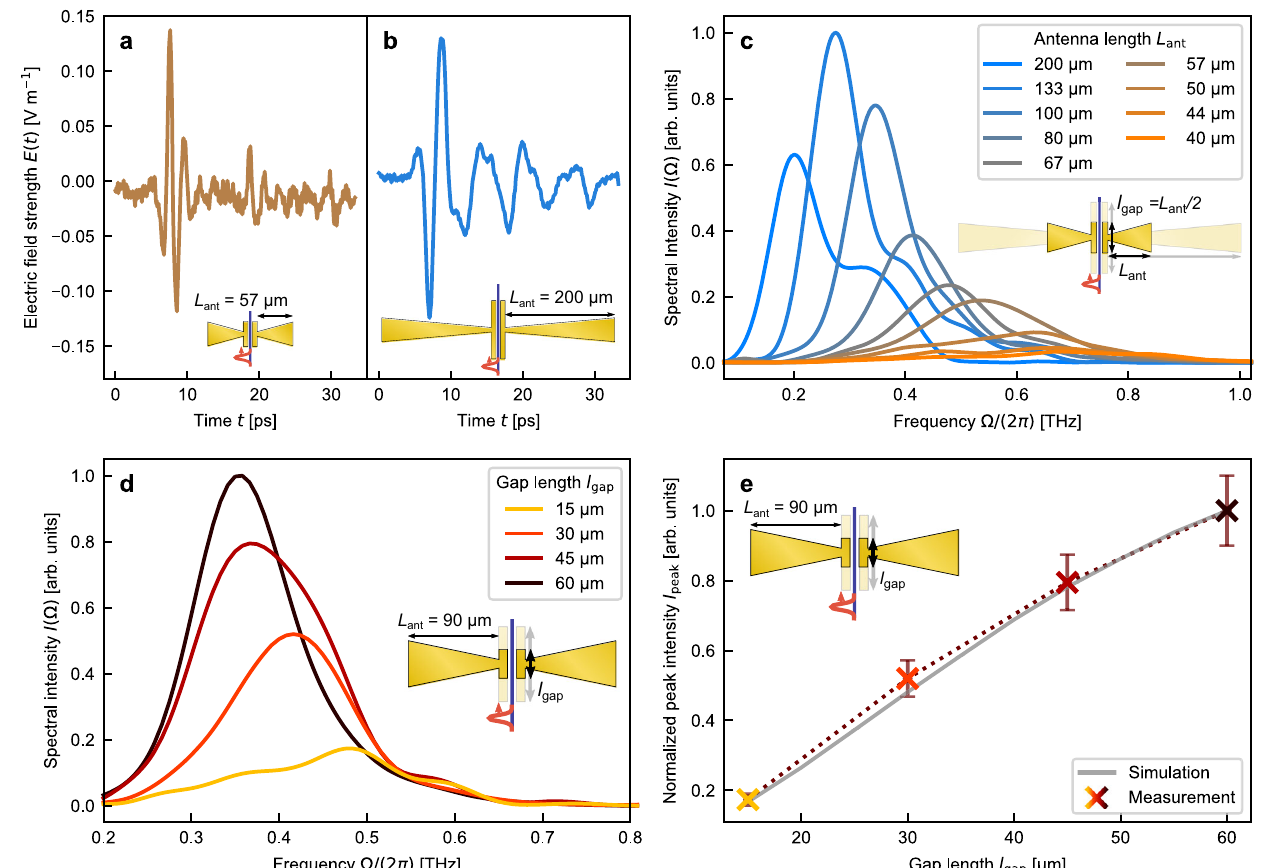
Fig. 2 | Modifying temporal and spectral properties of the THz waveforms by antenna design. a , b Time-domain trace of the electric fi eld emitted by a single antennadevicewithanarmlength L ant =57 μ mand L ant =200 μ m,measured under identical experimental conditions. The antenna dimension, and its resonant fre- quencyin fl uencethecharacteristicsoftheemittedTHz fi eld:shorterantennaemits a few cycles of fast oscillations, whereas a longer antenna emits few slow oscilla- tions. c Spectral intensities emitted by antennas of sizes L ant =200 μ m to L ant =40 μ m are retrieved from the Fourier transforms of the time-traces signals shownin a and b .Thelinecolorischangingfromorangetoblueforincreasing L ant .